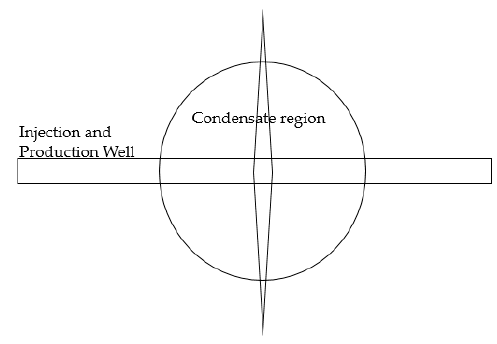
Figure 2. Huff-n-puff gas scenario in shale reservoirs.